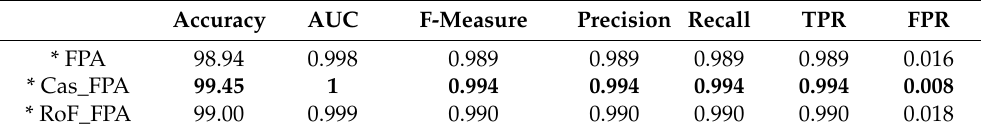
Table 10. Detection performances of FPA, Cas_FPA, and RoF_FPA on the Malgenome dataset.